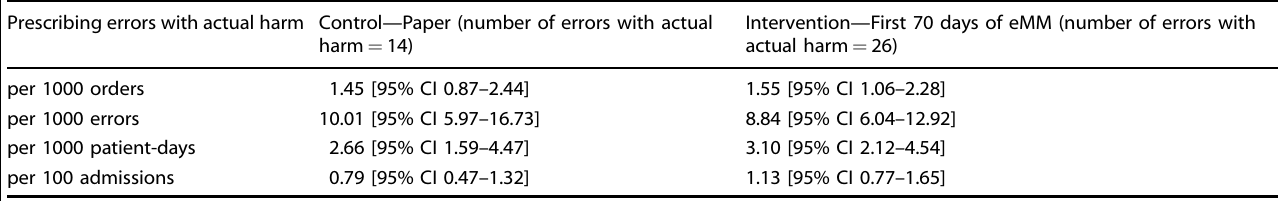
Table 6. Clinical prescribing errors associated with actual harm (actual ADEs) for control and short-term intervention periods. Prescribing errors with actual harm Control — Paper (number of errors with actual Intervention — First 70 days of eMM (number of errors with harm = 14) actual harm =